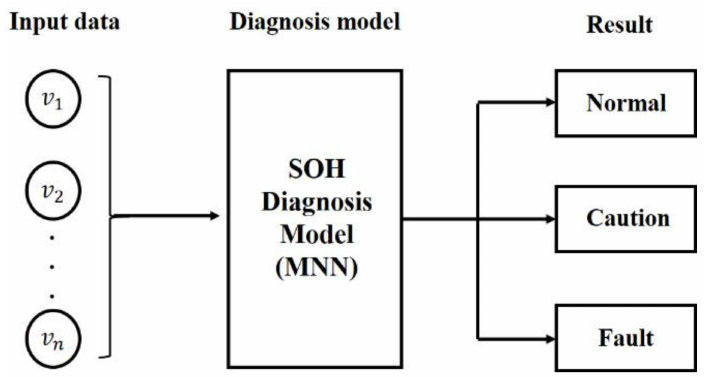
Figure 1. Structure of the SOH diagnosis